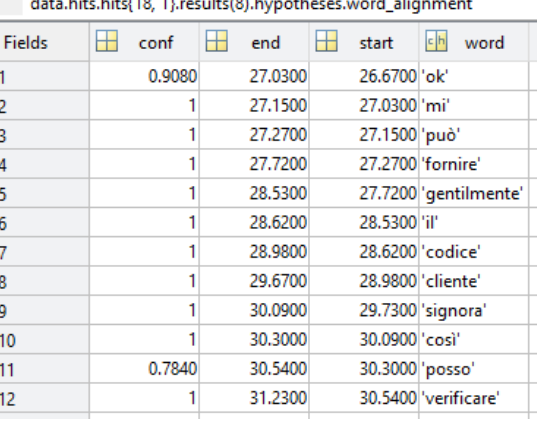
Figure 4. Words of the segment 8 of 26 in transcription 18 of 993. The Italian for the text: “ok, can you kindly provide me the customer code ma’am, so I can